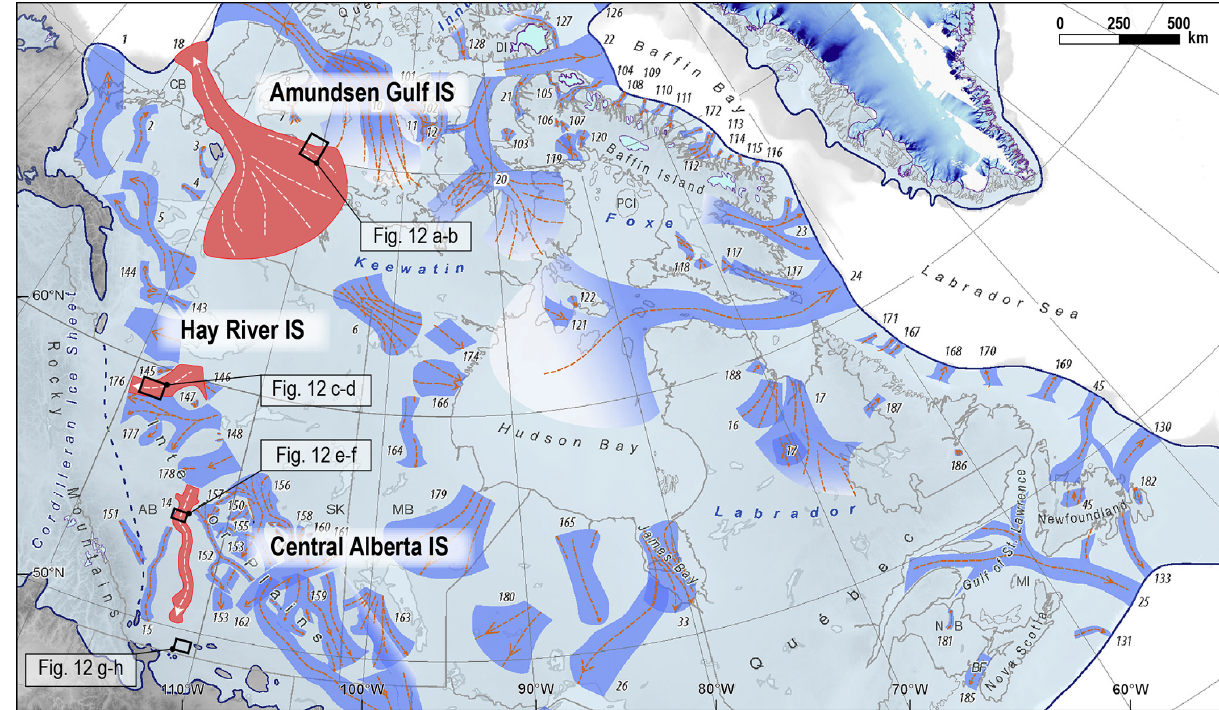
Figure 3. Extent of the North American Laurentide Ice Sheet during the Last Glacial Maximum with positions of known ice stream tracks (modified from Margold et al., 2018). The areas mapped in this study in three ice streams (Amundsen Gulf, Hay River and Central Alberta ice streams) are identified by black rectangles.